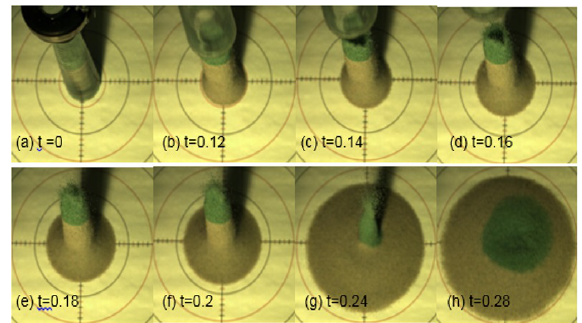
Figure 5. Snapshots of the granular collapse of a conical column performed for a = 5 . 82, we colored the upper 5 cm of the total height. Notice the existence of a peculiar orifice (crater) at t = 0 . 16 s and the asymmetry at the top of the mound caused by the skew of the grains at the upper part of the column.